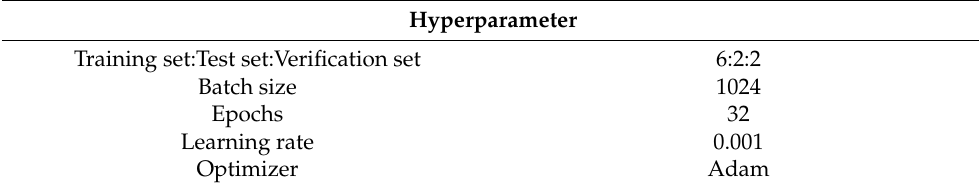
Figure 6. Comparison of noise reduction performance of different methods. Table 6. Hyperparameter of the classification network